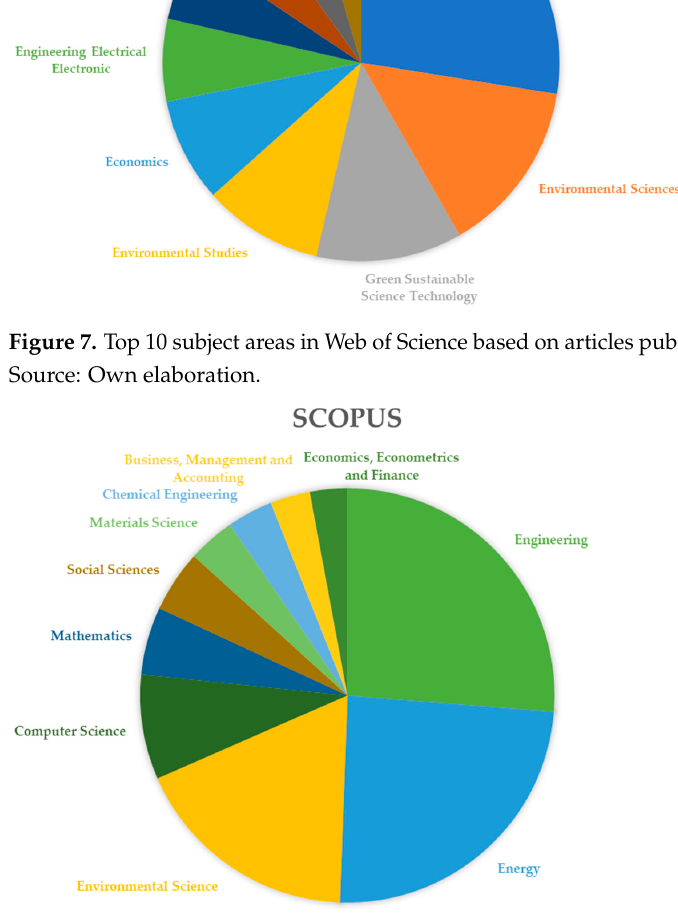
Figure 8. Top 10 subject areas in Scopus based on articles published annually using first query. Source: Own elaboration.